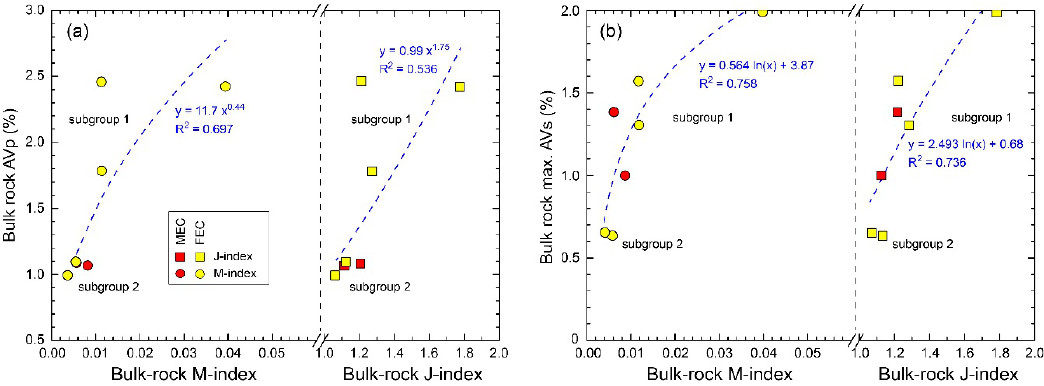
Figure 8. Relations between the phase volume proportions and the bulk rock ( a ) P-wave anisotropy (AVp) and ( b ) maximum S-wave polarization anisotropy (max. AVs) in the MEC and FEC. The blue dashed lines are the best-fitting curves along with their fitting functions for Amp.